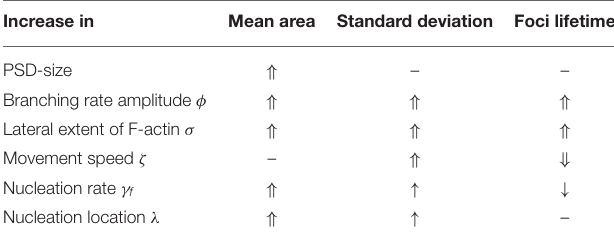
Frontiers in Synaptic Neuroscience |